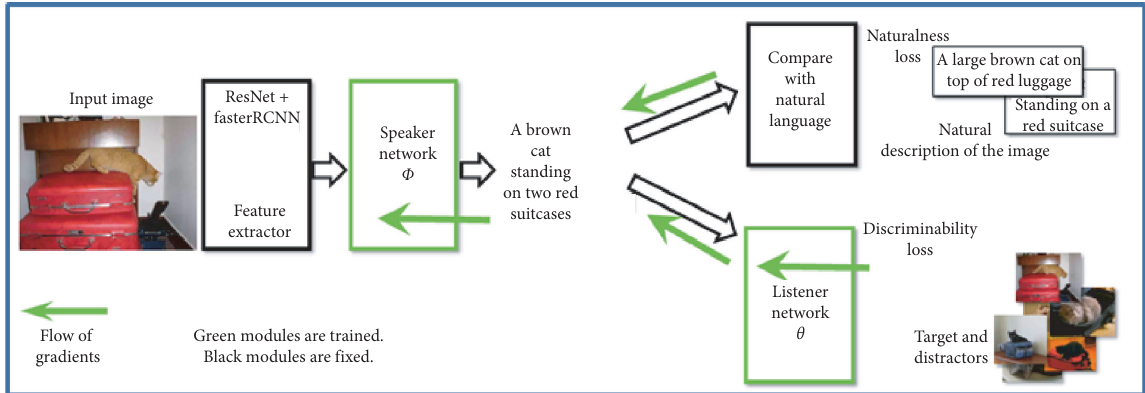
Figure 6: Sample architecture of a multimodal image captioning network [111].